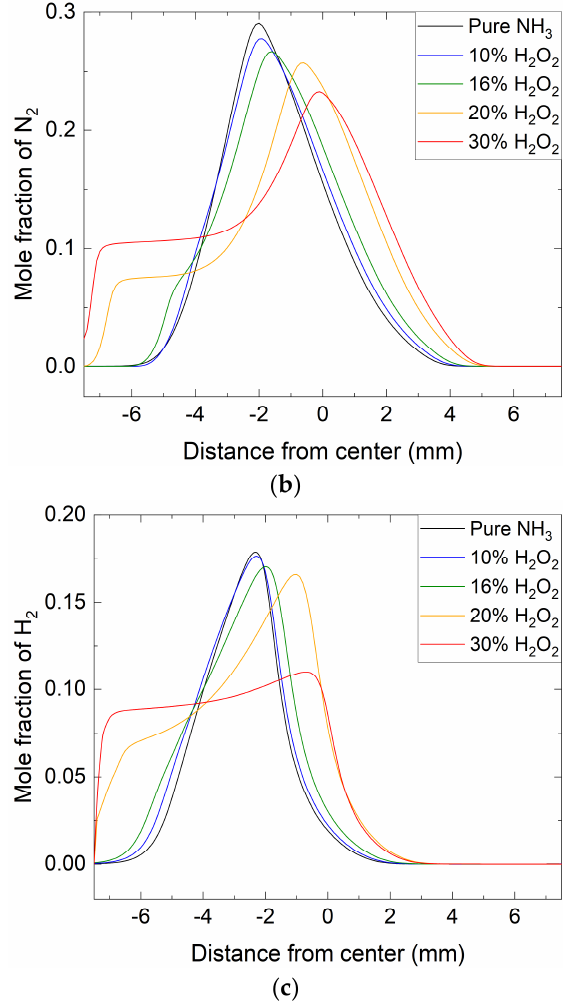
Figure 7. H 2 O ( a ), N 2 ( b ), and H 2 ( c ) mole fraction distributions along the burner center line. H 2 O, N 2 , and H 2 are all produced near the fuel nozzle in sizeable mole fractions when